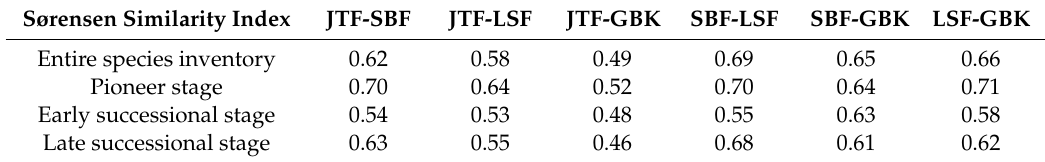
Table 2. Sørensen similarity index [49] calculated for comparisons of the entire species inventories of the glacier forelands studied as well separately for pioneer, early, and late successional stages. Sørensen Similarity Index JTF-SBF JTF-LSF JTF-GBK SBF-LSF SBF-GBK